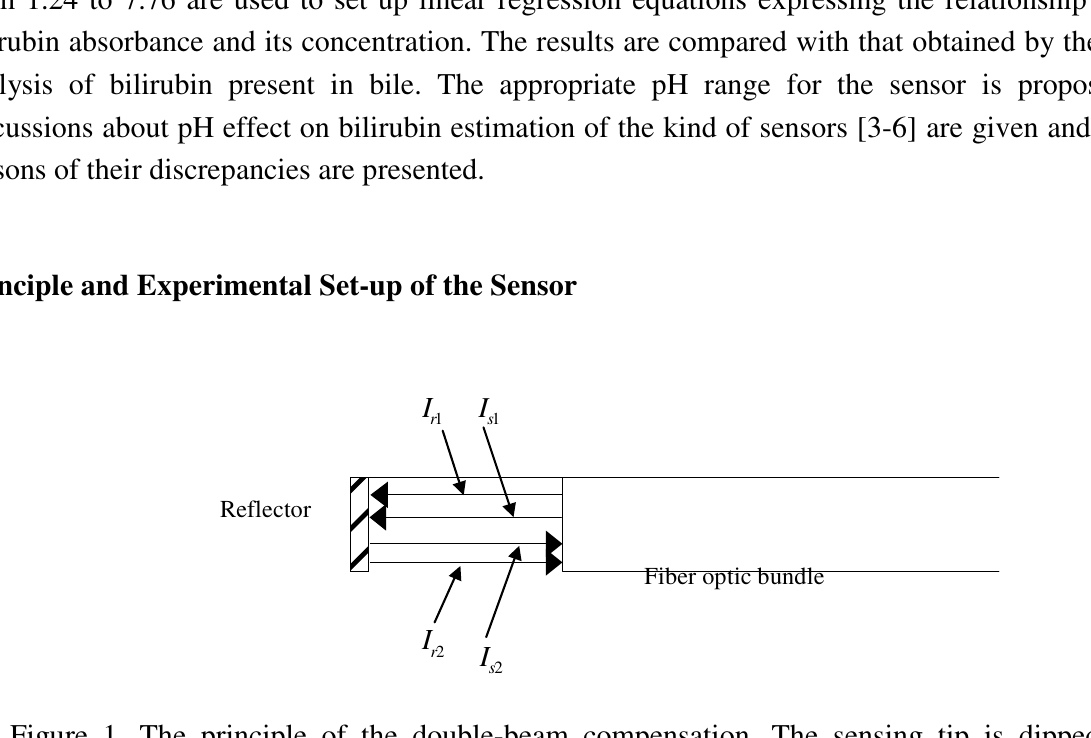
Figure 1. The principle of the double-beam compensation. The sensing tip is dipped into sample solution containing an absorbing substance. Figure 1. The reference and signal lights (